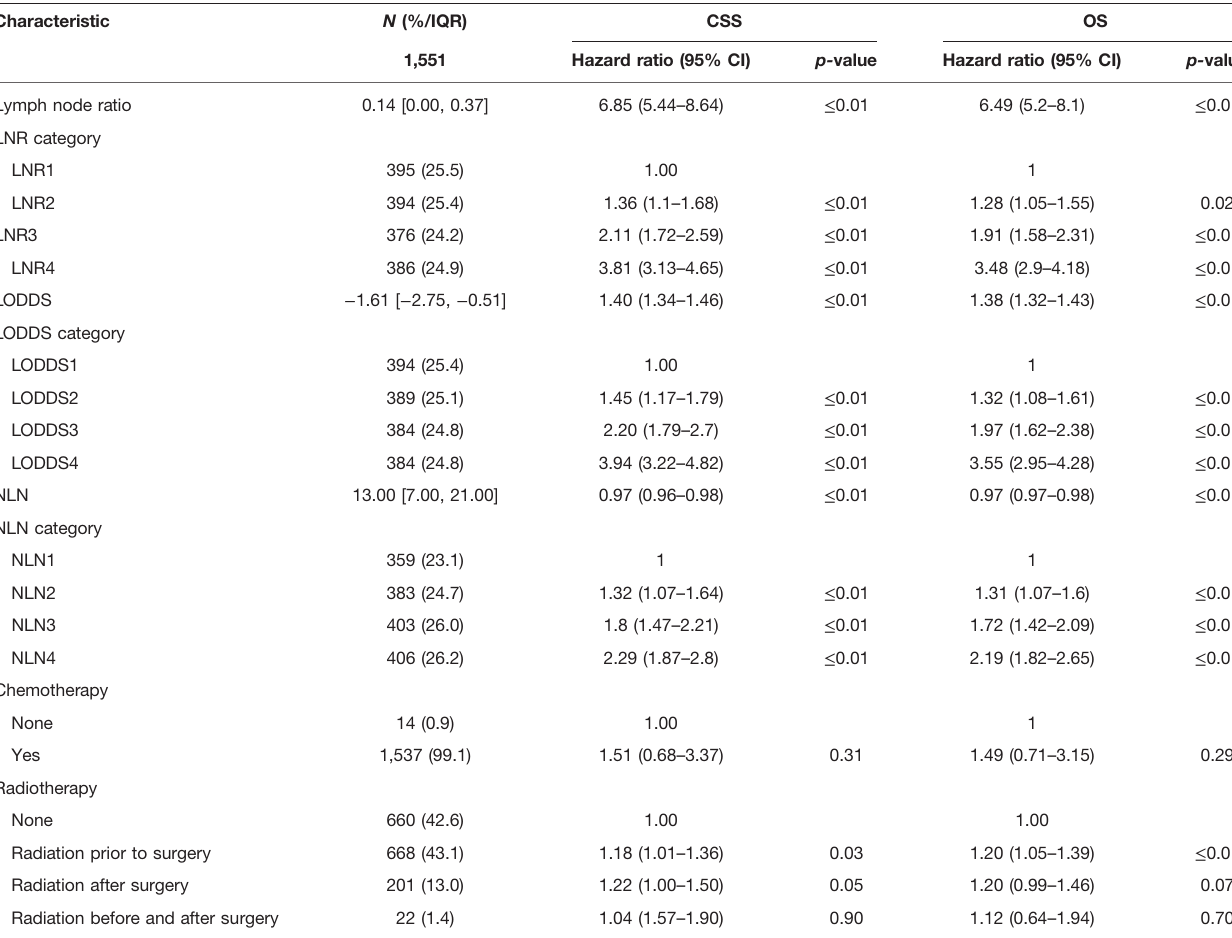
Figure 3 , based on the analysis of ROC curves, when regarded as the categorical variable, LNR and LODDS showed the